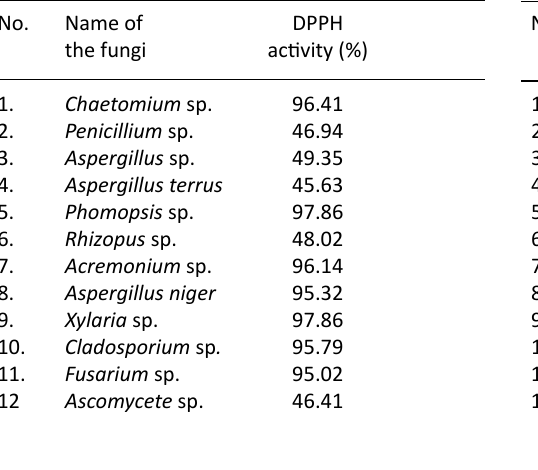
Table 5. Half maximal inhibitory concentration (IC crude endophytic fungal Ethyl acetate